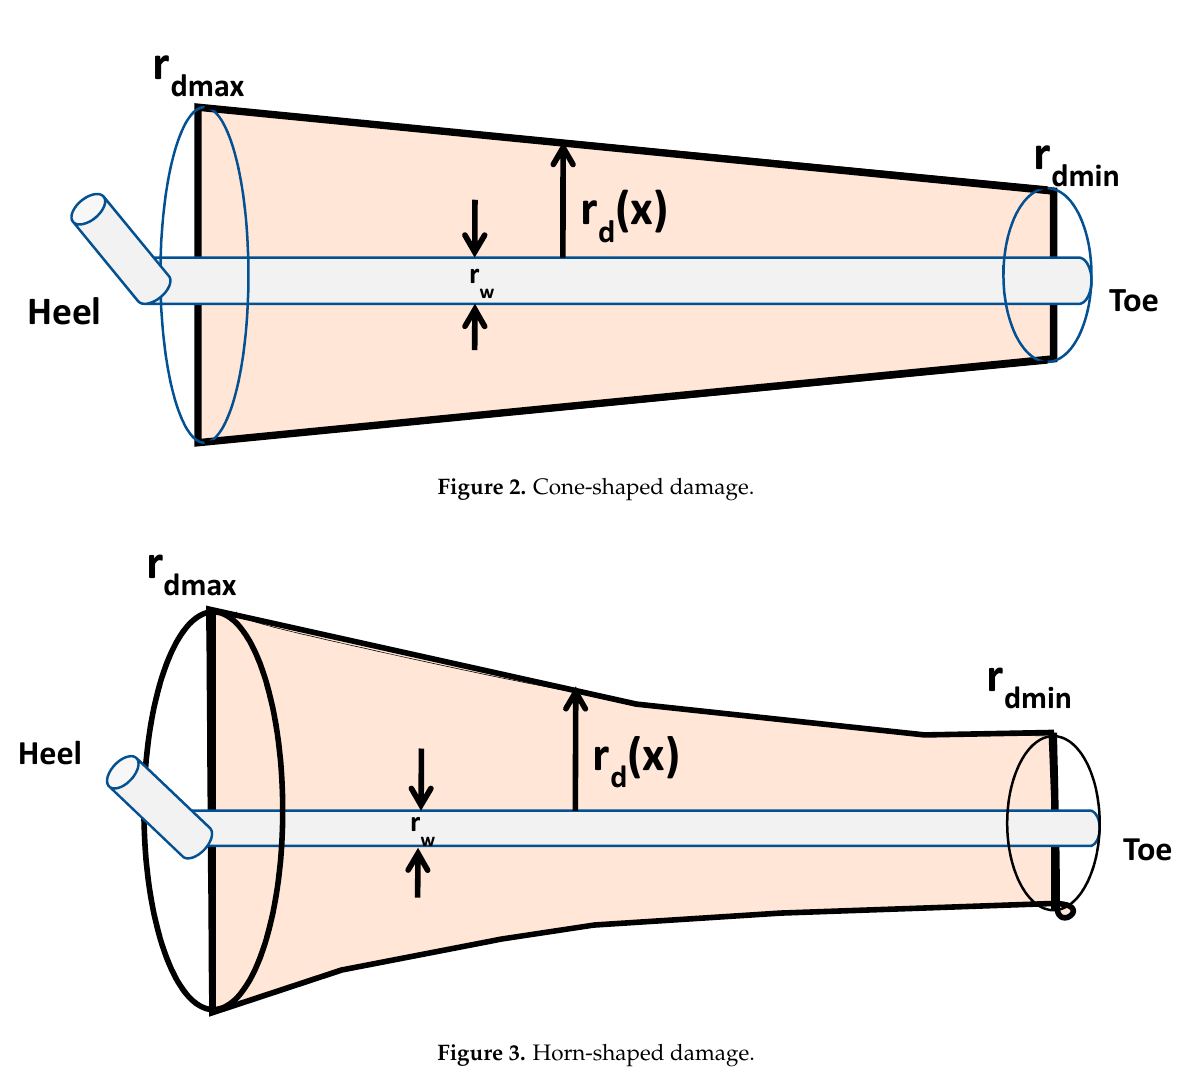
Figure 3. Horn ‐ shaped damage. Figure 3. Horn-shaped